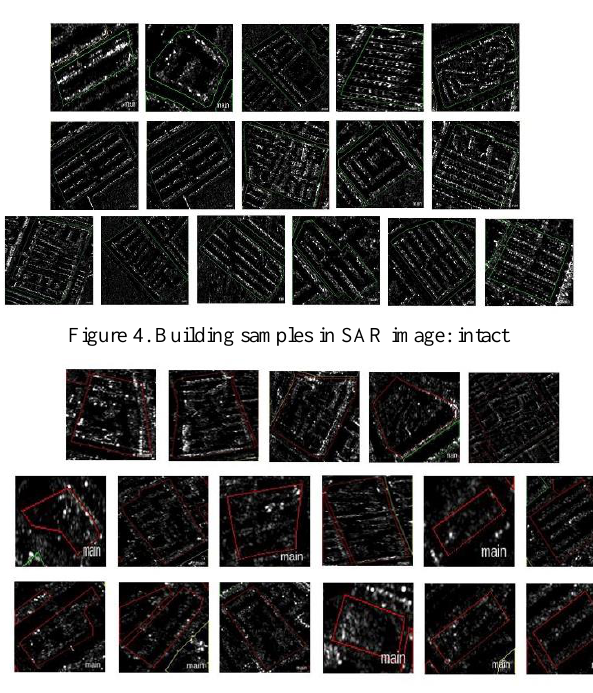
Figure 5. Building samples in SAR image: severely damaged Figure 6 gives the results of the statistical analysis of experiment. These results suggest that the intact geometry and the obvious shadow information make the intact buildings after the earthquake have a good consistency in the texture characteristics. On the contrary, destroyed buildings have different forms of damage, resulting in a variety of texture features. Nevertheless, the values of the texture feature can still be distinguished from intact buildings.